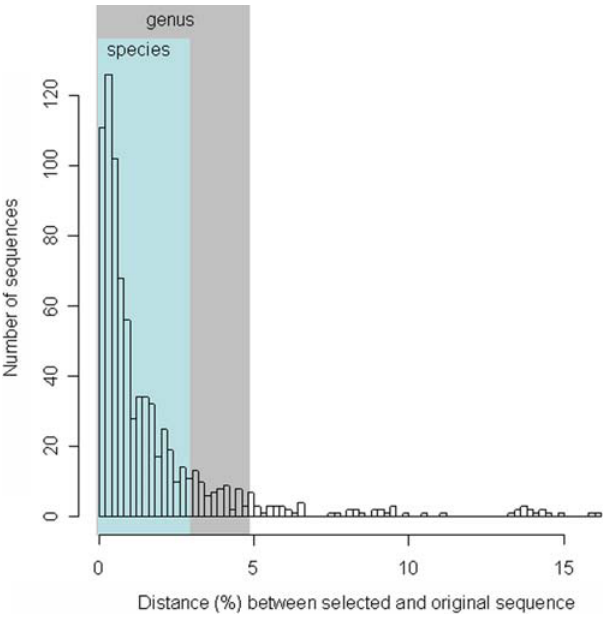
Figure 2. Taxonomic classification accuracy. Distribution of sequence distances (measured over the whole sequence lengths) between original sequence and the selected reference sequence, when 59 bp corresponding to minimal pyrosequencing reads were extracted from 1000 randomly selected RDP sequences and assigned to reference RDP sequences according to the procedure described in the Materials and Methods section (in this case the 1000 sequences had first been removed from the BLAST